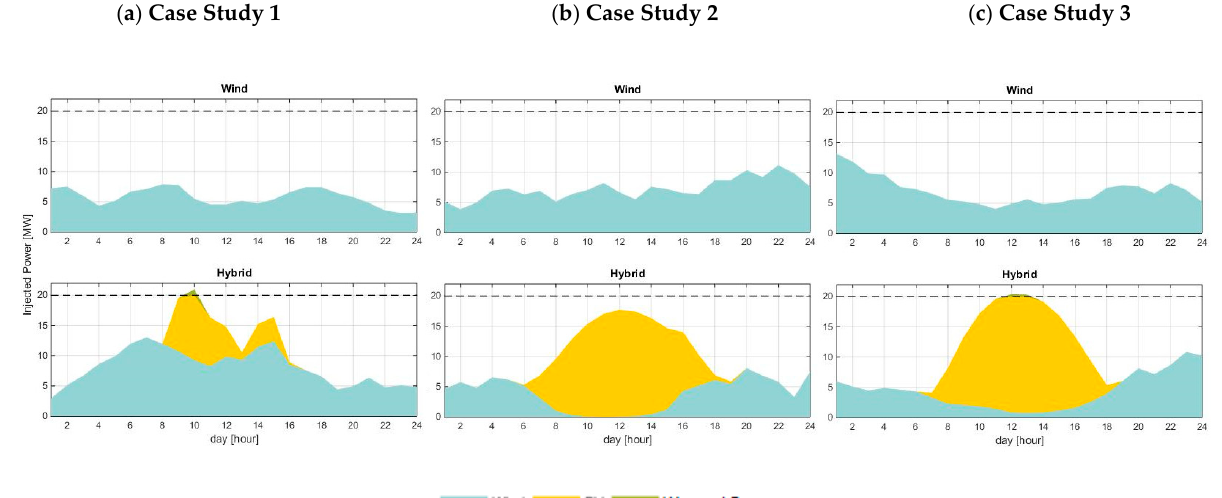
Figure 7. Daily production per technology for the typical average generation day profile of each technology. The representative days are different for each scenario.